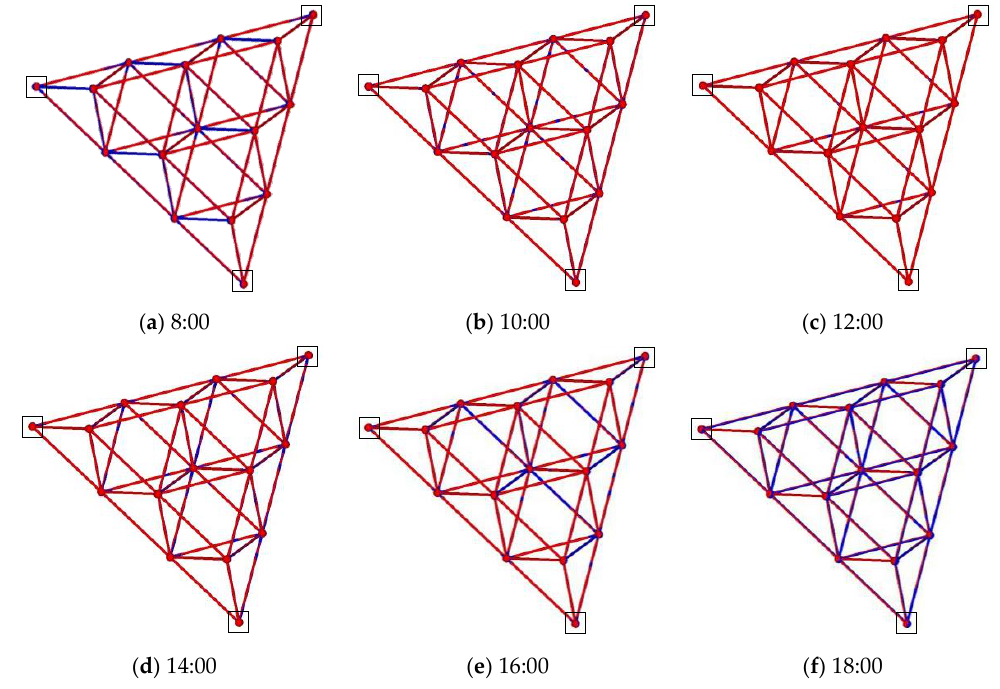
Figure 9. Shadow distribution of the spatial grid structure model at representative moments. Black boxes indicate cross plate supports.